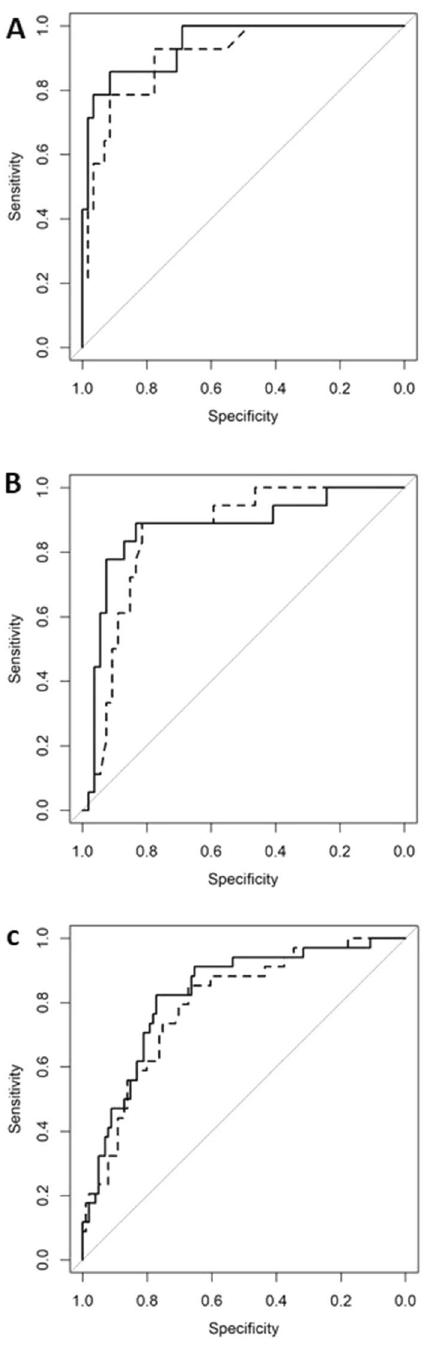
Figure 2. ROC curves for the multivariable logistic regression models with or without candidate miRs expression. ( A ) Estimation of prior CVD in men. ( B ) Estimation of pathological cIMT in men. ( C ) Estimation of pathological cIMT in women. Models were assessed by logistic regression analysis and were initially adjusted for age, RA disease onset, BMI, ischemic heart disease, peripheral artery disease, ictus, creatinine, and treatments. Solid line = baseline models. Dotted line = baseline model + candidate